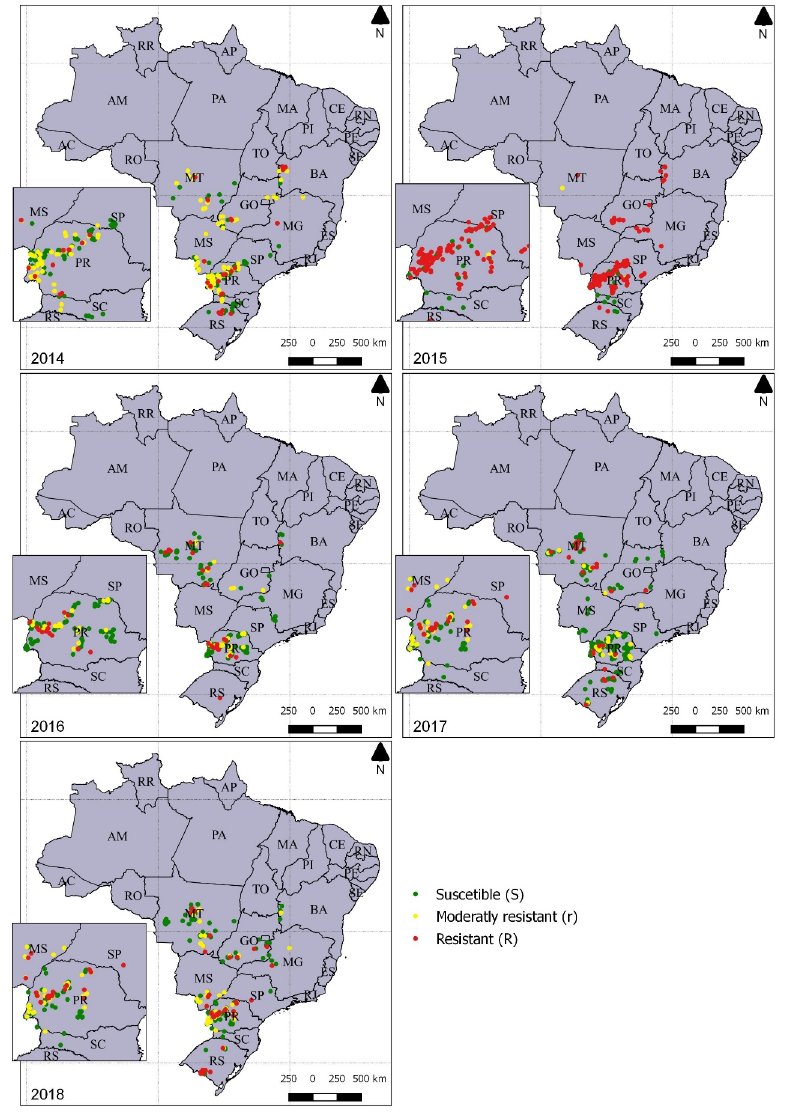
Figure 3. Distribution of Conyza spp. populations resistant to chlorimuron-ethyl in Brazil between 2014 and